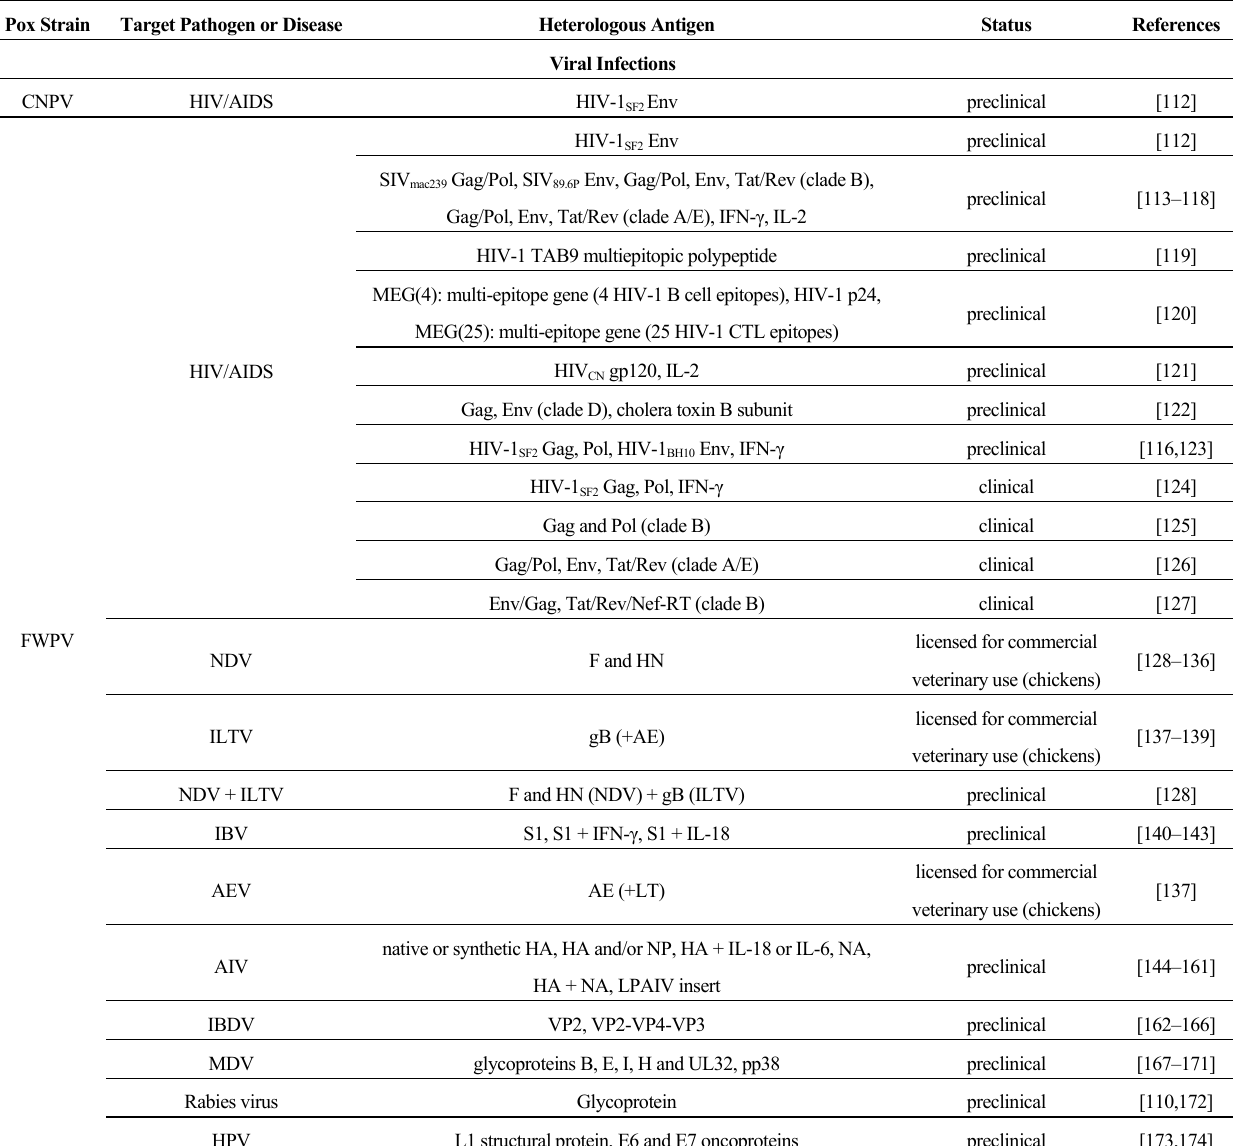
Table 4. Vaccine applications of avipoxvirus-based